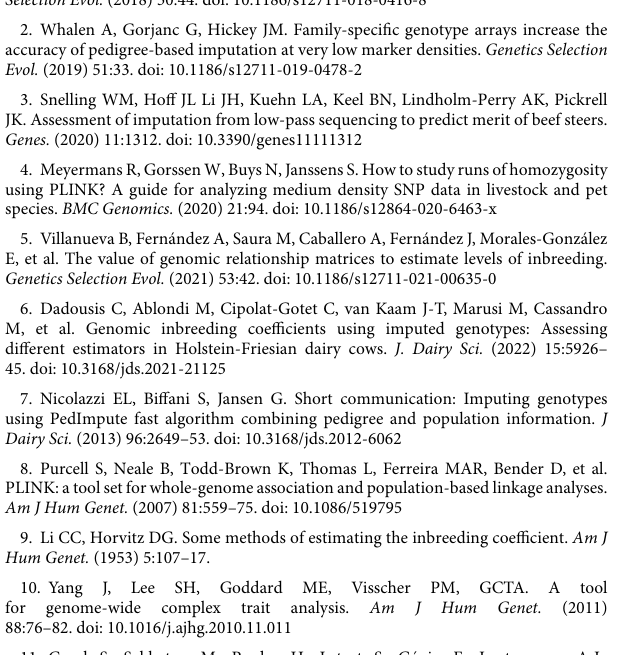
Illumina Infinium BovineHD BeadChip, (B) GeneSeek Genomic Profiler HD-150K, (C) GeneSeek Genomic Profiler 3, (D) GeneSeek Genomic Profiler 4, (E) GeneSeek MD, and (F) Labogena MD. In gray color the overall